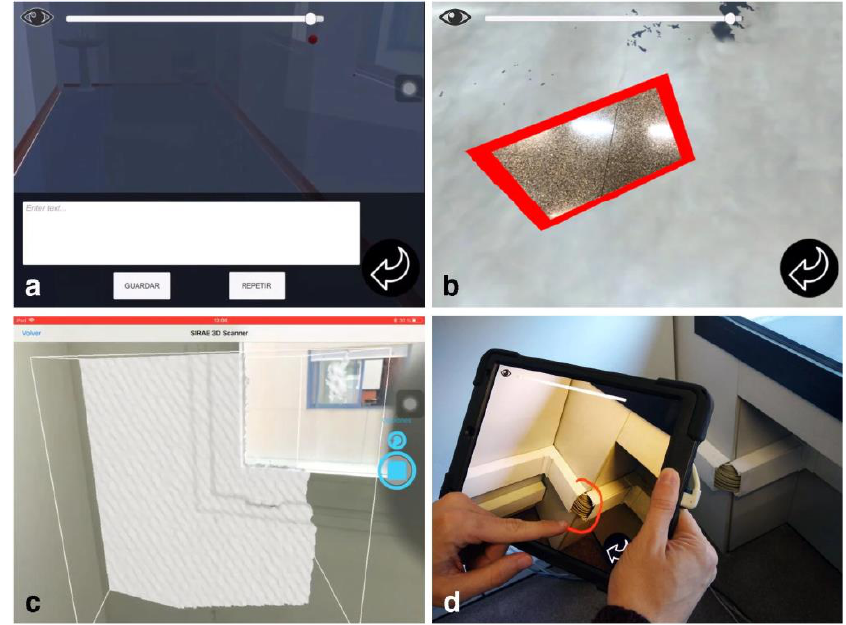
Figure 17. ( a ) User interface for text annotation, ( b ) photographic annotation projection on the floor, ( c ) scanning the corner of a window to build its 3D model, ( d ) the stroke-type annotation [105].